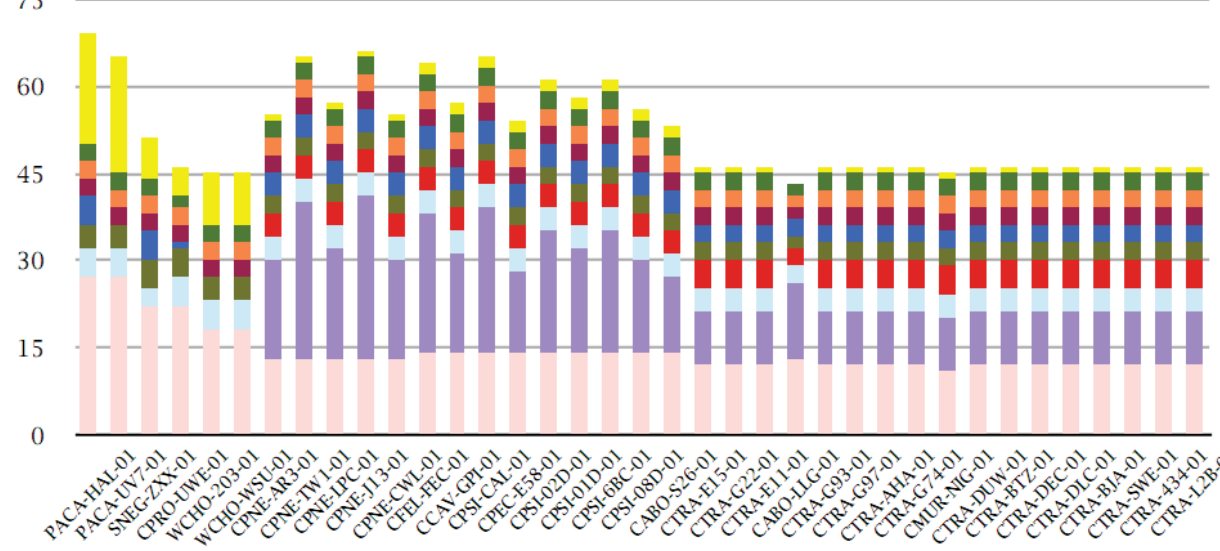
Figure 2. Top ten multi-member families within the pangenome. Genomes (with full COGENT-like codes) are shown on the x-axis, sorted by total protein-coding gene count (see also Table 1). Absolute cumulative counts of multi-member families are shown on the y-axis (displayed in the figure legend from left to right and then top to bottom, e.g., ABC transporter permeases, POMPs, type III secretion system ATPases, etc. according to size, see text), color coded according to figure